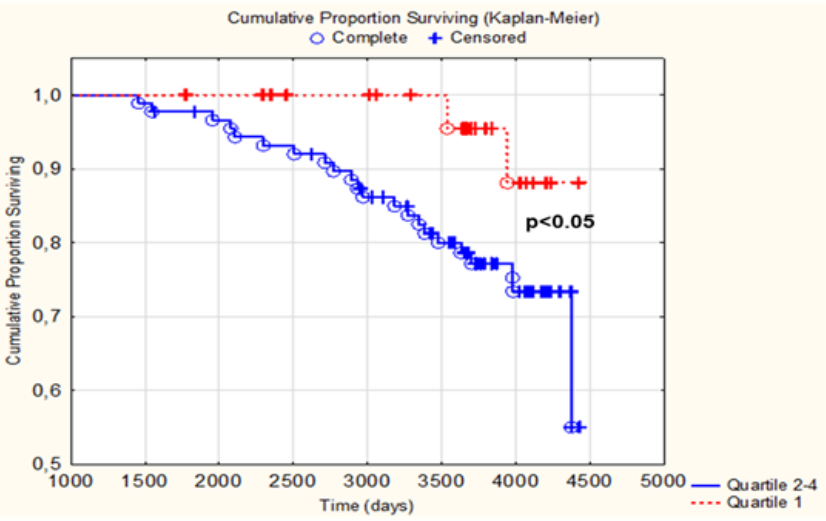
Figure 4. Kaplan–Meier graph illustrating those with a telomere shortening in the 1st quartile vs. quartiles 2–4 regarding CV mortality within 10 years. The red line represents quartile 1 and the blue line represents quartiles 2–4.